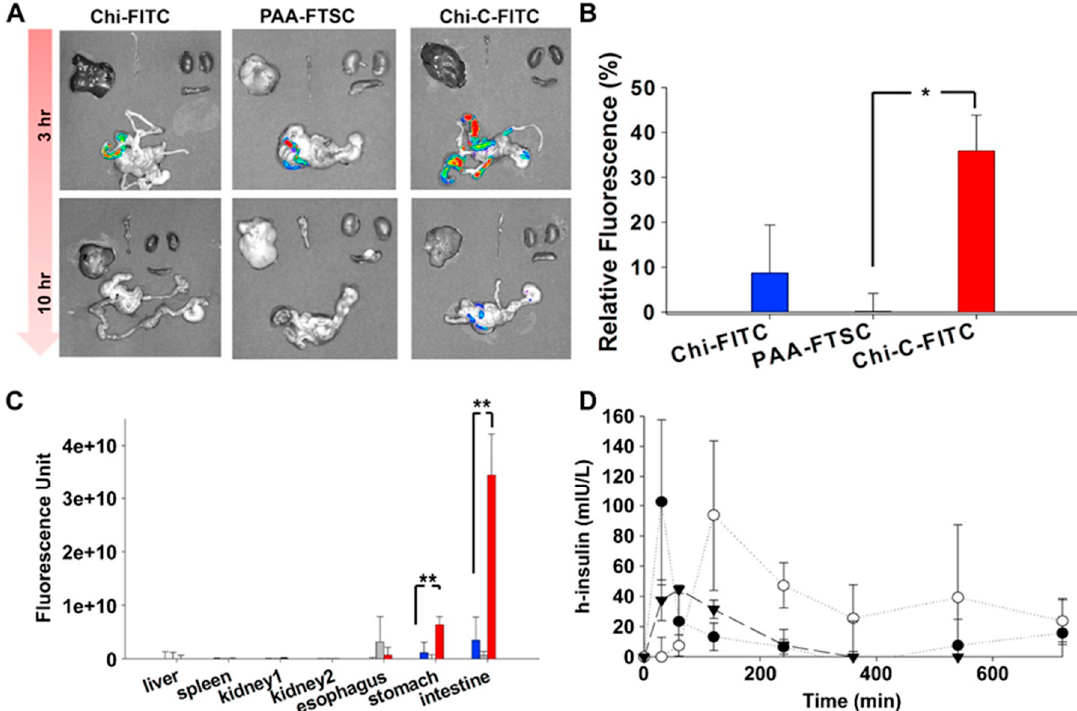
Figure 20. Chitosan-fluorescein isothiocyanate (Chi-FITC), polyacrylic acid-fluorescein-5- thiosemicarbazide (PAA-FTSC) and chitosan-catechol-fluorescein isothiocyanate (Chi-C-FITC) were orally administered to BALB/c mice and the animals were euthanized after 3 or 10 h. ( A ) The extracted organs were imaged using in vivo imaging system. ( B ) The relative fluorescence intensity of Chi-FITC, PAA-FTSC and Chi-C-FITC in the gastrointestinal tract (esophagus, stomach and intestine) at 10 h after administration. ( C ) The fluorescence in the liver, spleen, kidneys, esophagus, stomach, and small/large intestine at 10 h after administration are shown (mean ± SD, n = 3 mice/time point). (* denotes statistical significant difference at p < 0.05, ** indicates p < 0.005). ( D ) The human (h)-insulin (closed triangle), h-insulin/chitosan (closed circle) and h-insulin/chitosan-catechol (open circle) were orally administered to Wistar rats and blood insulin concentration was measured using enzyme-linked immunosorbent assay (ELISA) ( n = 4 rats/time point). Reprinted from [141] with permission of Elsevier.